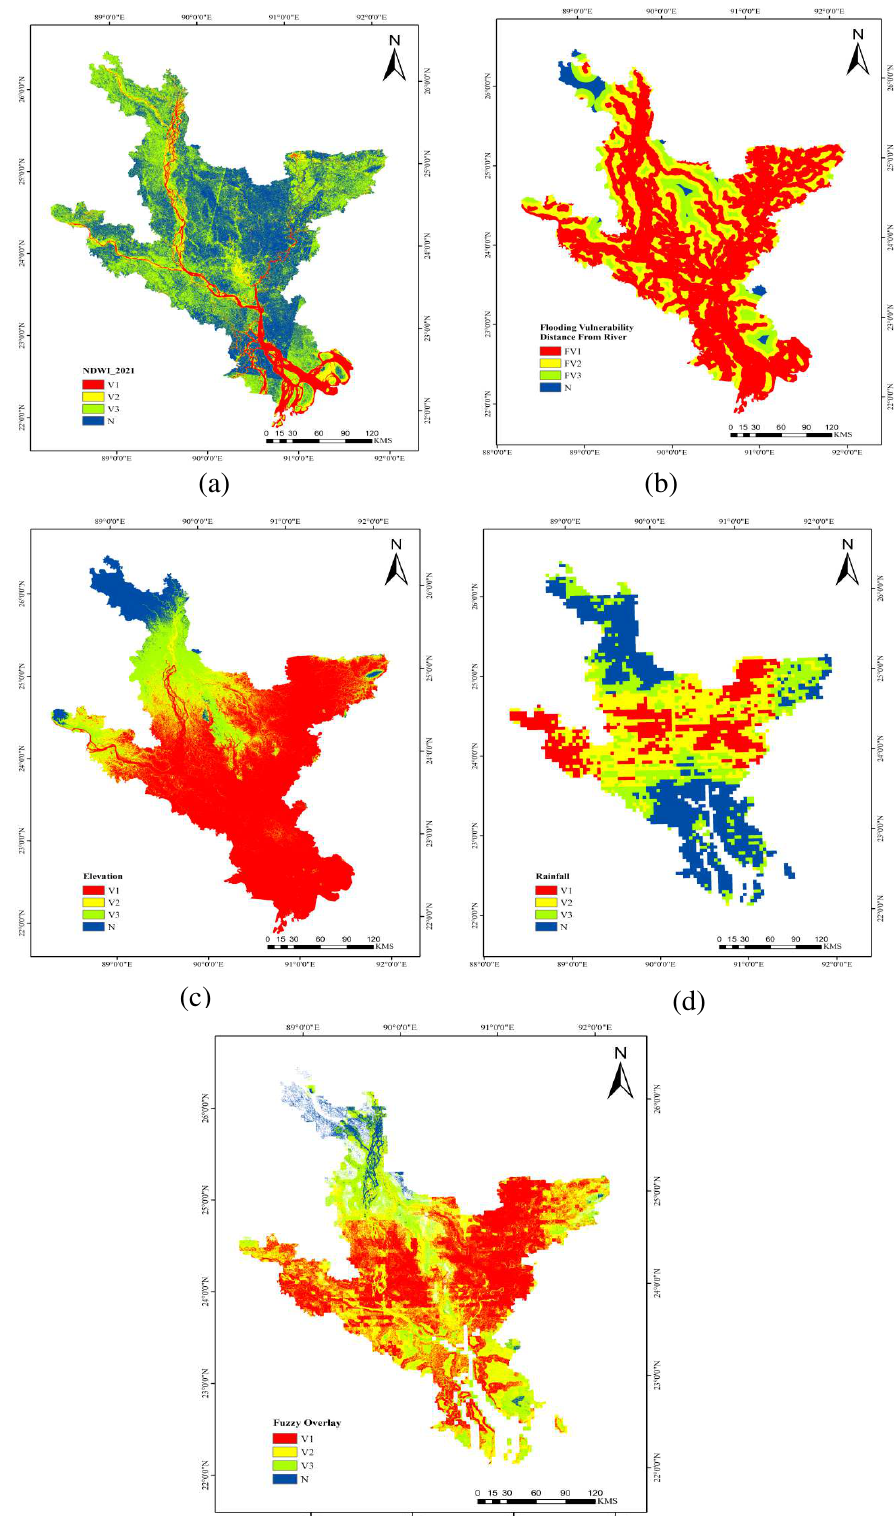
Figure 9. Reclassified vulnerability map of different indices for agricultural land use; ( a ) NDWI; ( b ) Distance from the river; ( c ) Elevation; ( d ) Rainfall, and ( e ) Fuzzy gamma overlay, where V1, V2, V3, and N refer to high, moderate, marginal, and nonvulnerable areas, respectively.